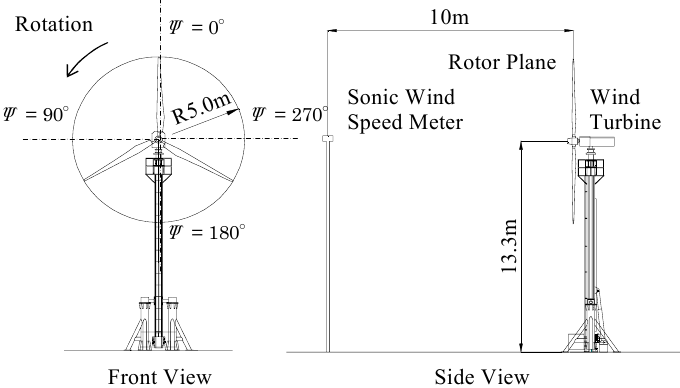
Fig.3 Location of test wind turbine and wind speed meter